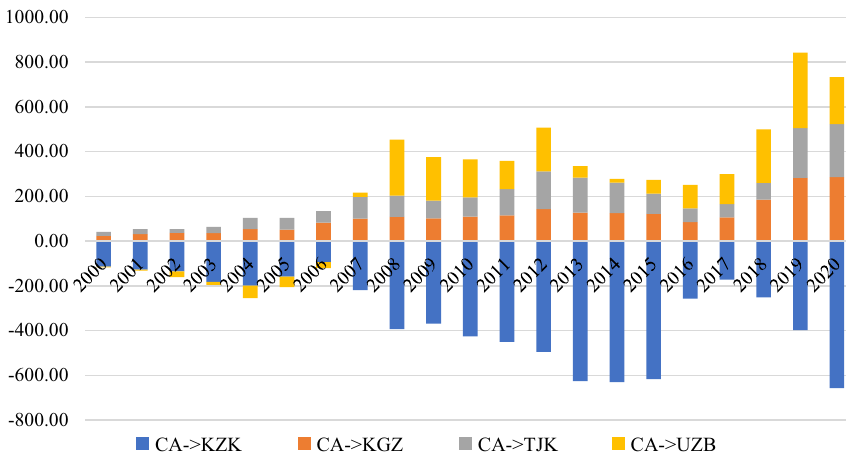
Fig. 1 Intra‑regional trade of Central Asia (million dollars)